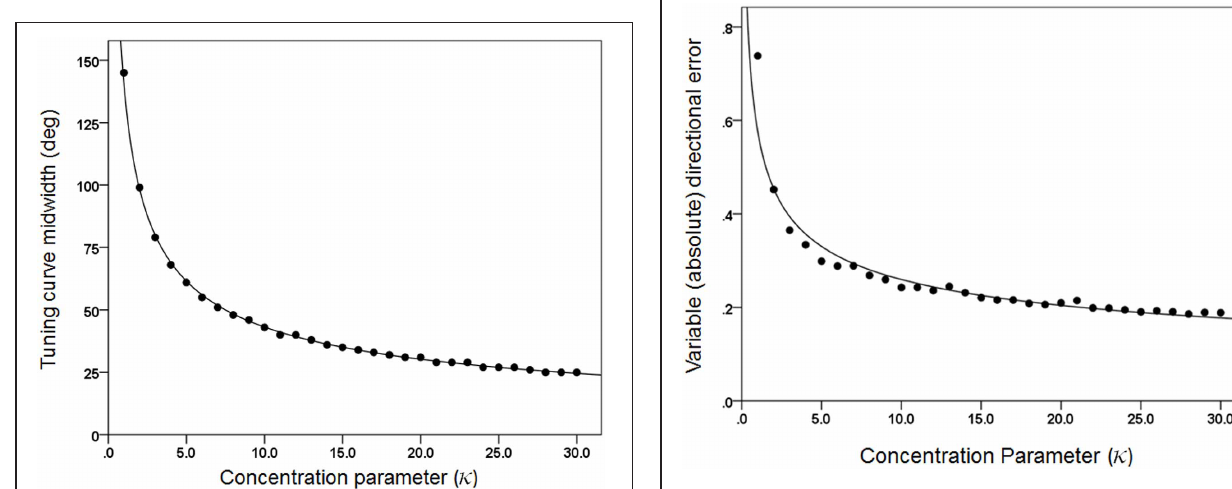
FIGURE 2 | The midwidth of the tuning curve is plotted against κ . The fitted line is a power function fit ( R 2 = 0 . 999). N = 30.